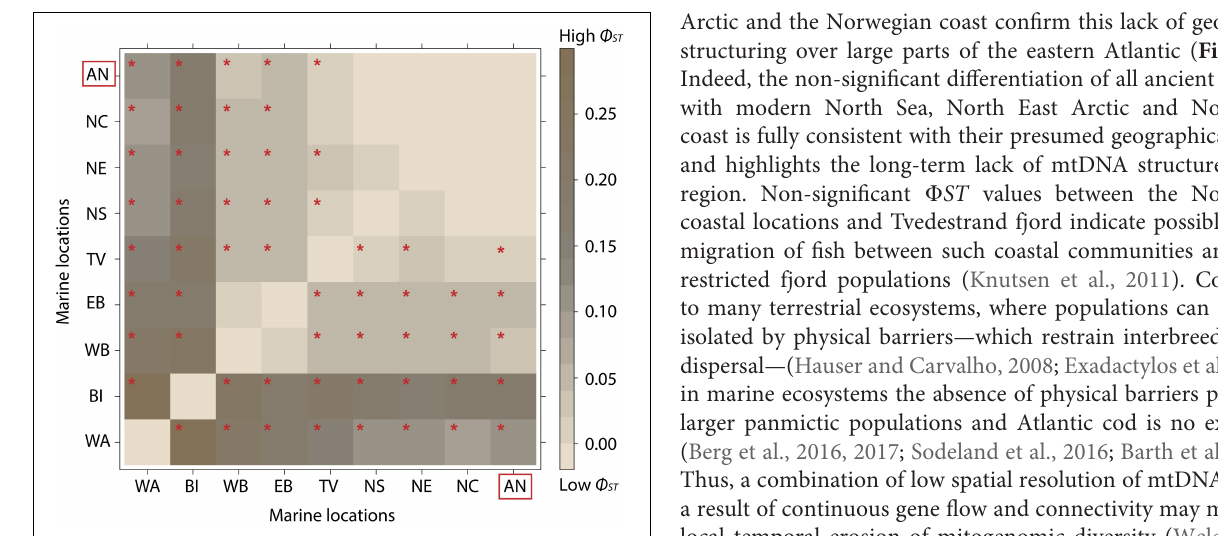
subsets ( Figure 5 ). A population expansion of Atlantic cod